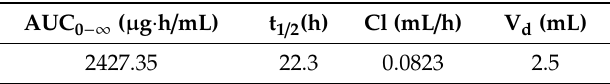
Table 6. Drug exposure expressed as AUC 0 −∞ after first dose administration and the parameters, t 1 / 2 , Cl, and V d , calculated by linear